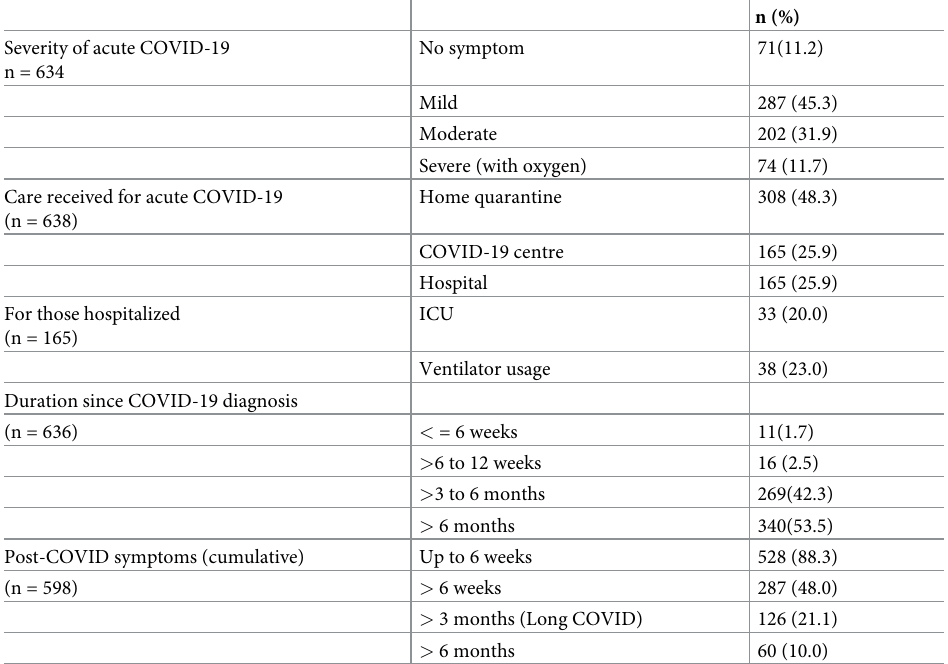
Table 2. Acute COVID-19 information of